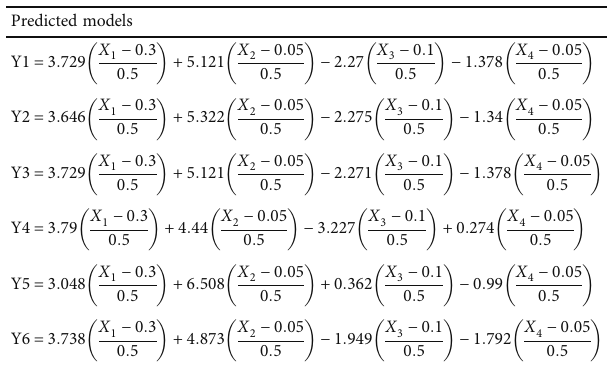
Table 4: The e ff ect of di ff erent combinations studied. Term Estimation Standard